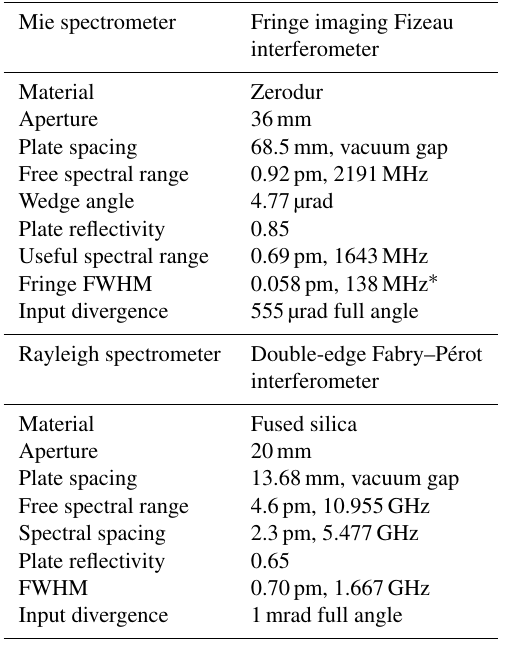
Table 1. Specifications of the Mie spectrometer and the Rayleigh spectrometer of the ALADIN instrument (Reitebuch et al.,